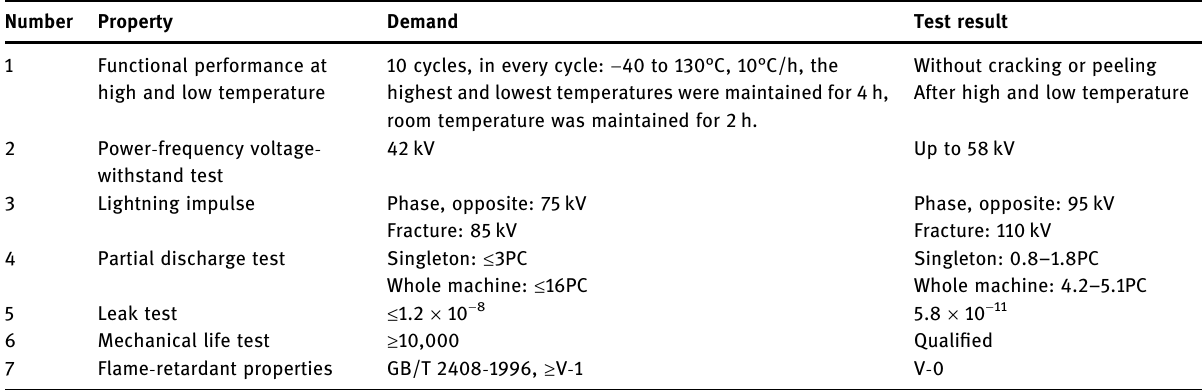
Table 4: Final functional performance of the plate Number